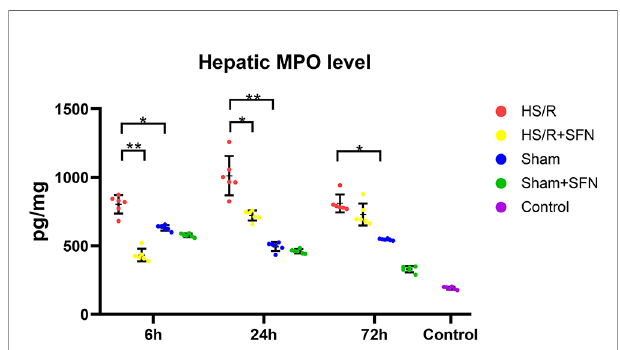
FIGURE 5 | Hepatic MPO activity (n=6 in each group). C57/BL6 WT mice following HS/R or sham surgery with HS/R + SFN or sham + SFN or without the administration of SFN (HS/R groups or sham groups). The results are expressed as pg/ml, data = mean ± SD (*p < 0.05, **p < 0.01; One-way ANOVA followed by Tukey ’ s post hoc test).